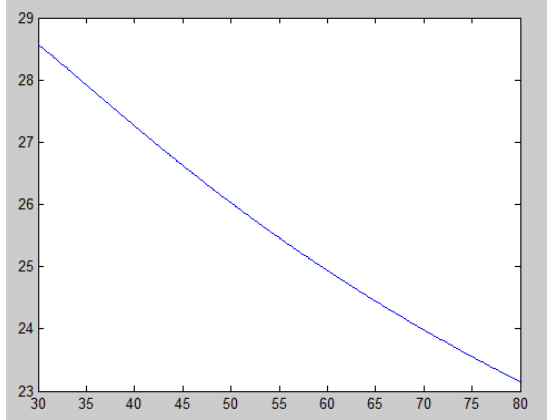
Figure 3. Partial graph of f ( q ) .